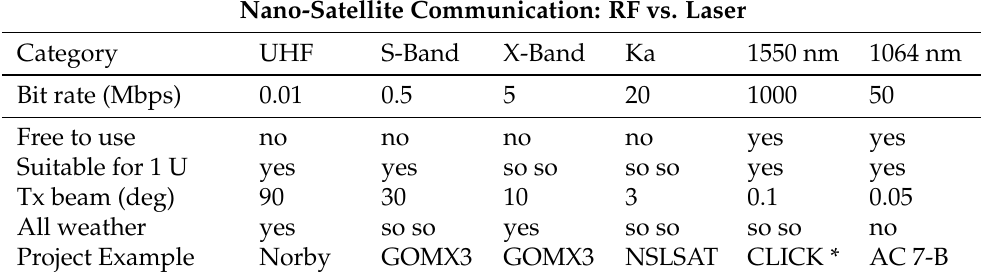
Table 1. Communication technologies related to